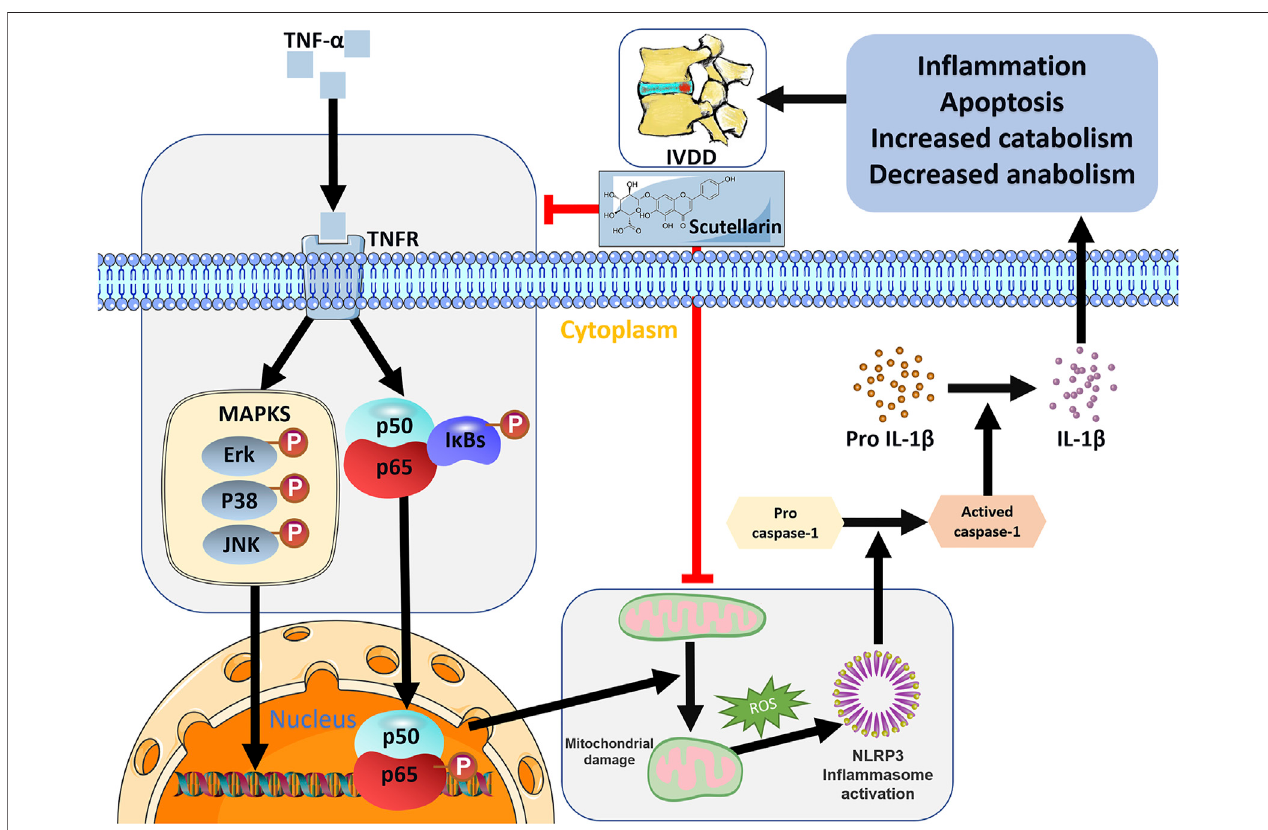
FIGURE 8 | Schematic depicting a proposed model for the function of scutellarin in intervertebral disc degeneration.